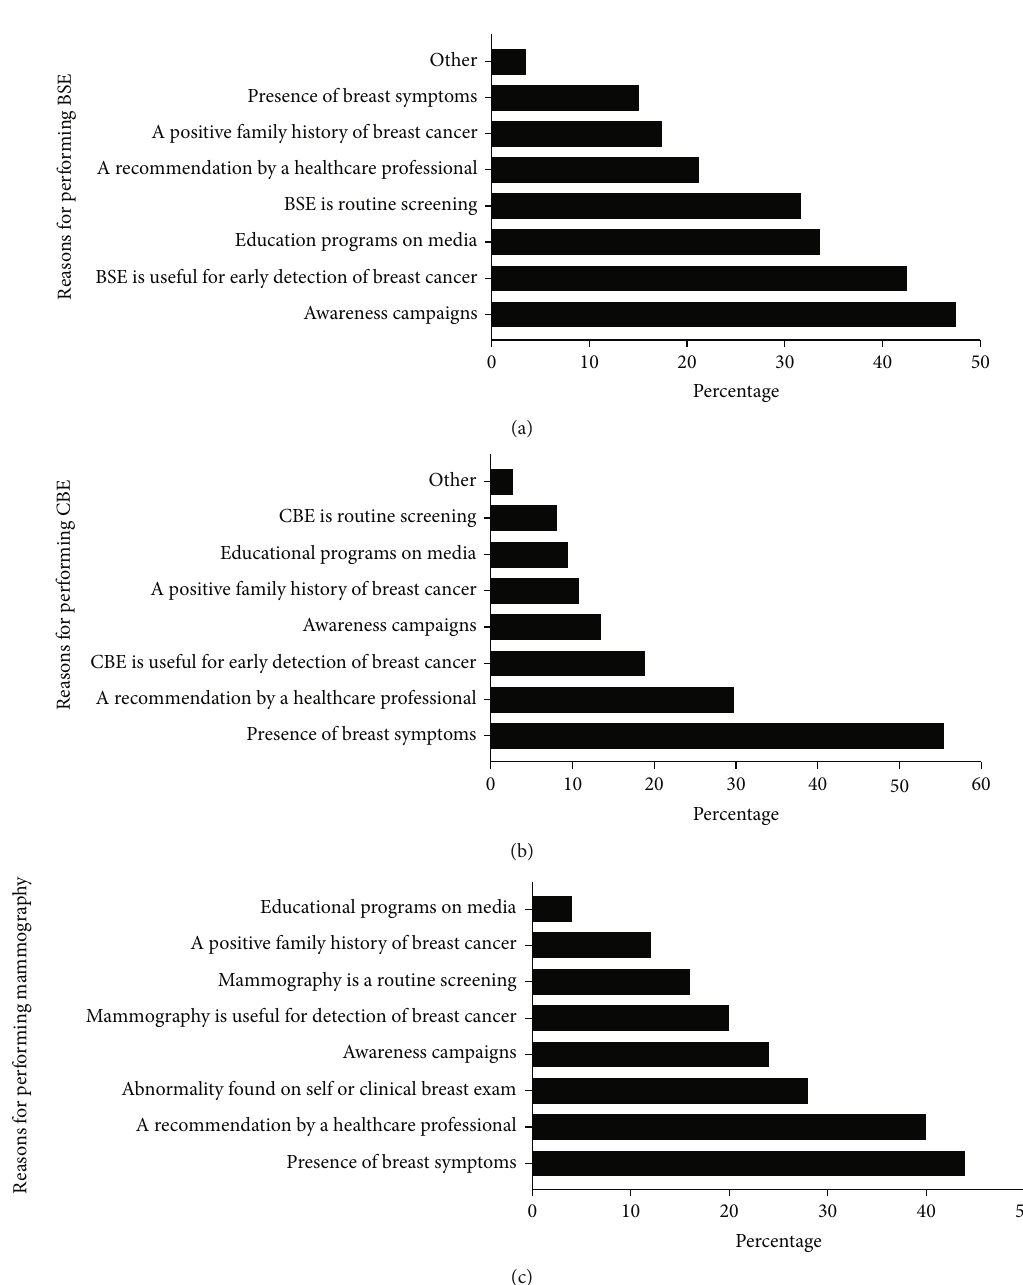
Figure 2: Reasons for performing the di ff erent screening methods for the early detection of breast cancer among community